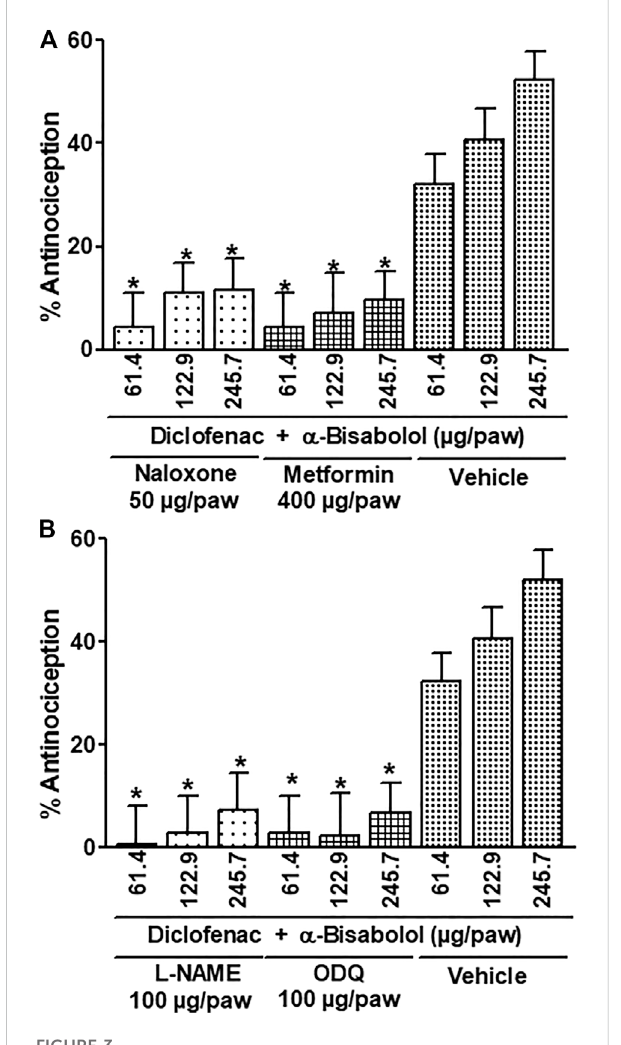
FIGURE 3 Effectofthelocalperipheralinjectionofnaloxone (A) ,metformin (A) , L-NAME (B) or ODQ (B) on the antinociceptive activity of the α - Bisabolol-diclofenac combinations during the formalin test. Rats received a local injection of α -Bisabolol ( − 20 min), diclofenac ( − 13 min) and then the inhibitors ( − 7 min) into the right paw. Results are expressed as the antinociception percent on phase two. Each point corresponds to the mean ± SEM of 5-6 animals. *Signi fi cant difference from vehicle group ( p < 0.05) as determined by the analysis of variance followed by Dunnett ’ s test.